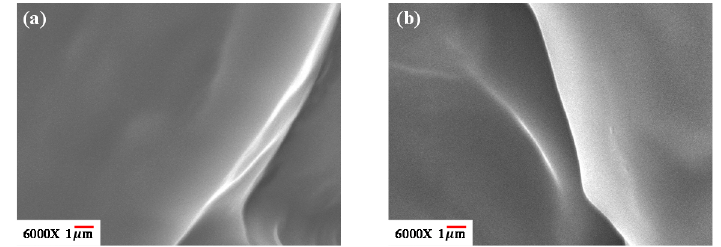
Figure 1. SEM cross-section morphologies for [EPrI][TFSI]/PHB blends with the compositions ( a ) 20/80 and ( b ) 40/60.